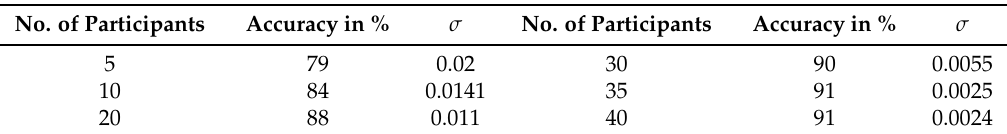
Table 4. The following table shows the relation between the accuracy and the number of participants chosen for evaluation. The number of participants was selected for 10 folds, and performance was evaluated on test data from a fixed number of 17 participants.